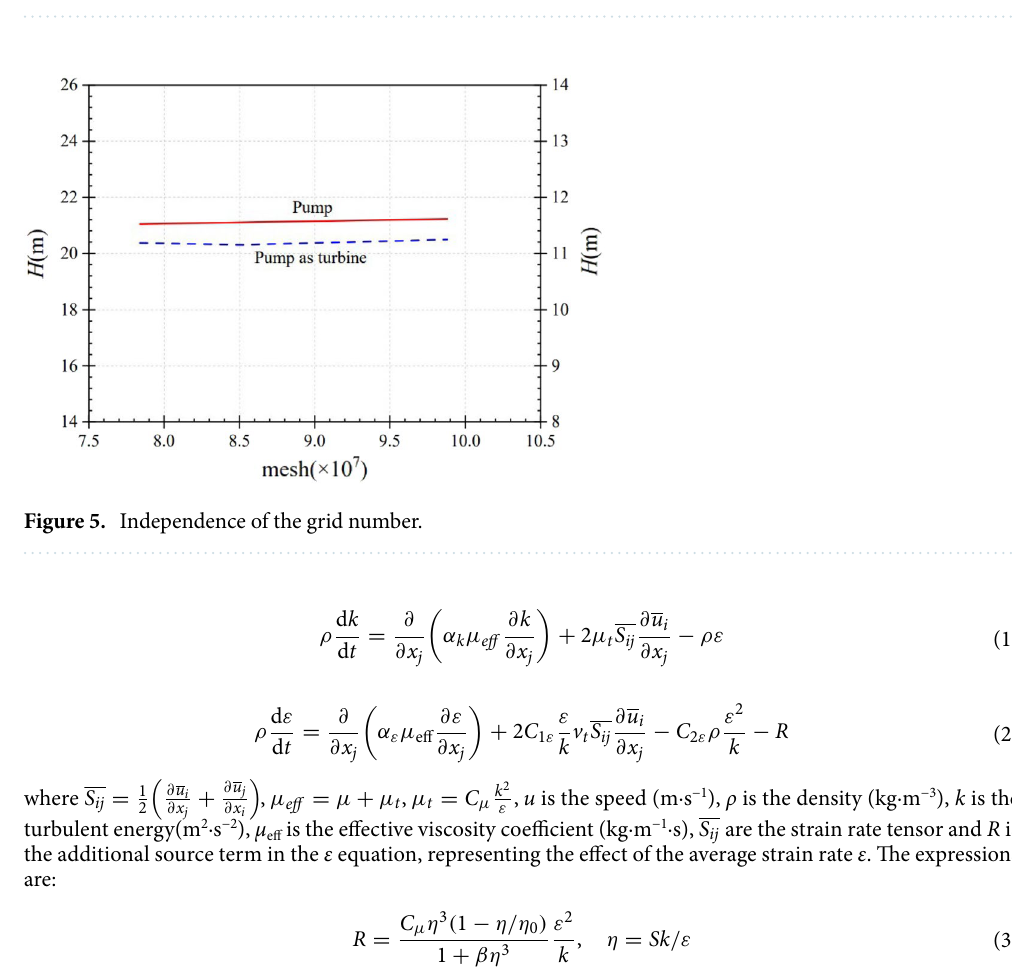
Figure 4. Partial grid diagram. ( a ) Booster pump, ( b ) Pump as turbine, ( c ) Valve.